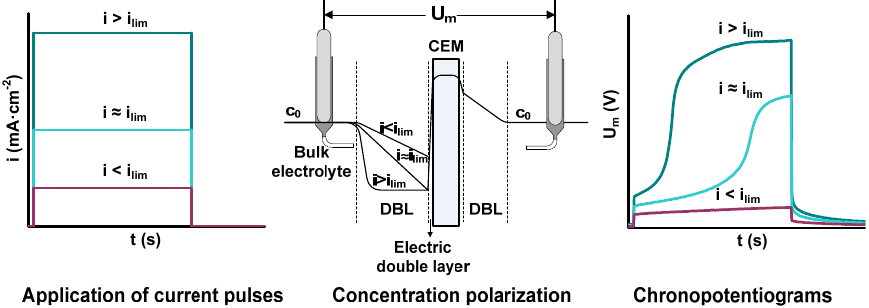
Figure 1. Correlation between the shape of the input applied current density, the profiles of concentration through the membrane system and the corresponding response of U m .